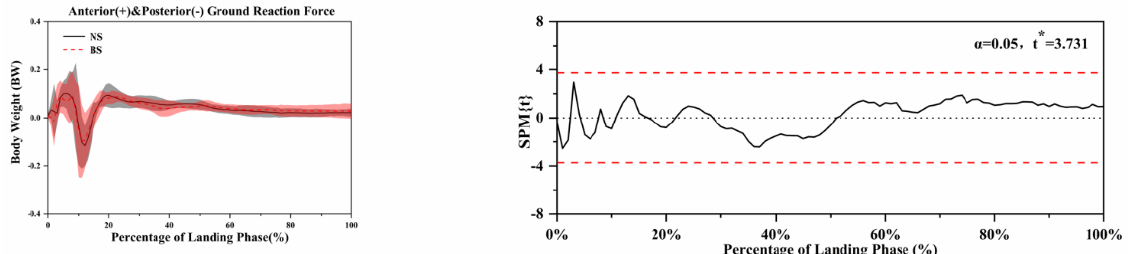
Figure 7. Descriptive results between NS and BS lower-limb statistical parametric mapping results for vertical ground reaction force during the SLL phase, t-values of the SPM for all participants (post hoc results; dashed red lines represent p = 0.05 level). Grey shaded areas display regions that have statistically significant differences. The scale on the left of each image shows the change in the joint angle and the value of t *. The scale of 0–100 below each image presents an SLL phase.